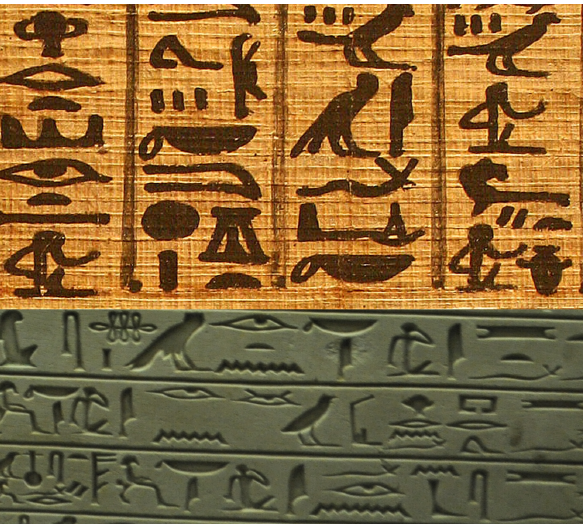
Figure 2. Examples of images (on different supports) belonging to our dataset: papyrus on the top and bas-relief on the